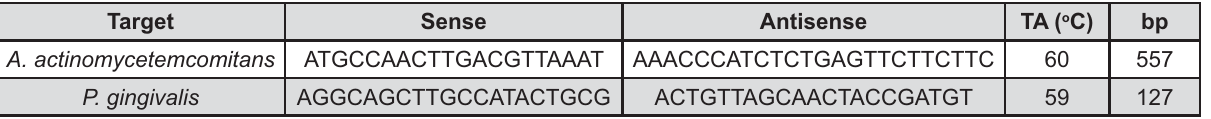
TA - annealing temperature; bp - base Figure 1- Primer sequences used in PCR tests and respective anneding temperature and the predicted amplicon size